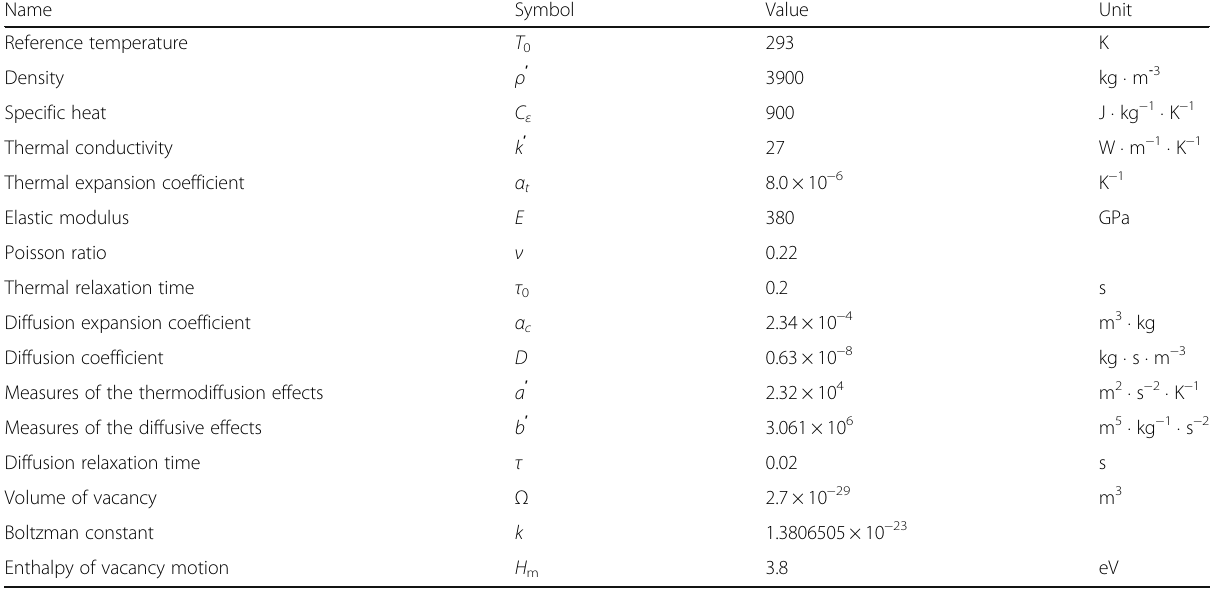
Table 1 The thermoelastic diffusion parameters of Al 2 O 3